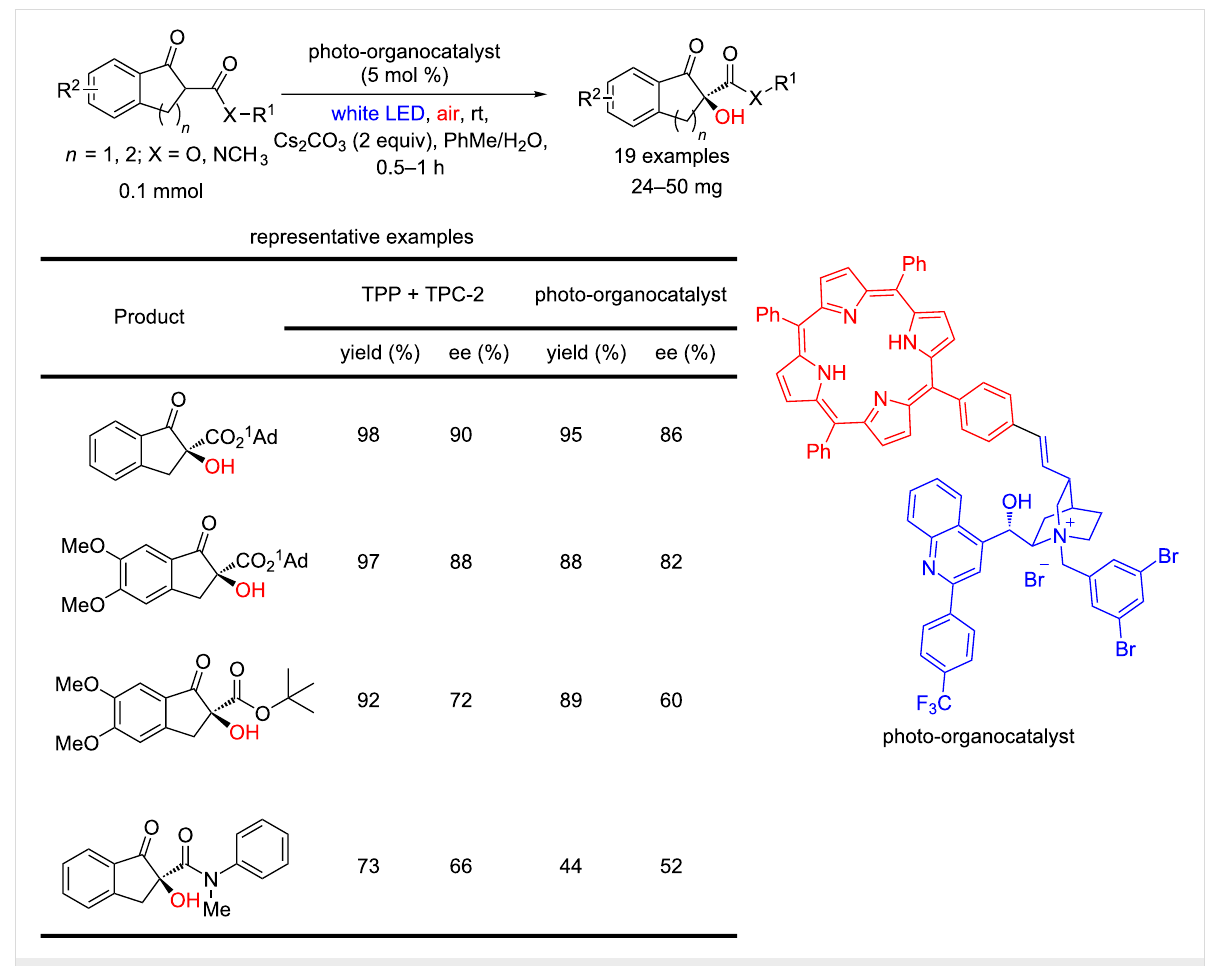
Scheme 43: Bifunctional photo-organocatalyst used for the asymmetric oxidation of β -keto esters and β -keto amides by singlet